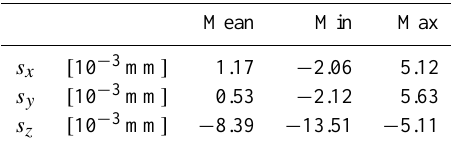
Table 2. Statistical values of the components of the displacement error vector s inside the operative